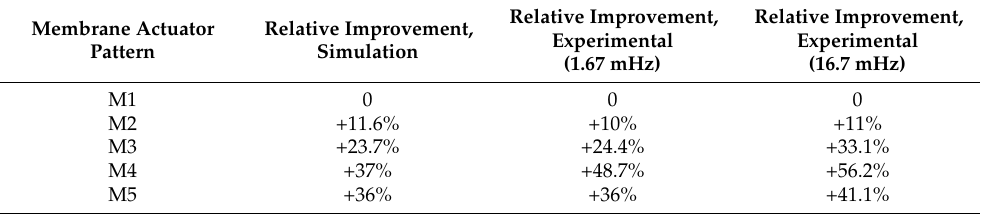
Table 1. Simulated and experimental displacements (% improvement over the M1 membrane) of membranes with different cutting designs (M1–M5, Scheme 1) (relative to